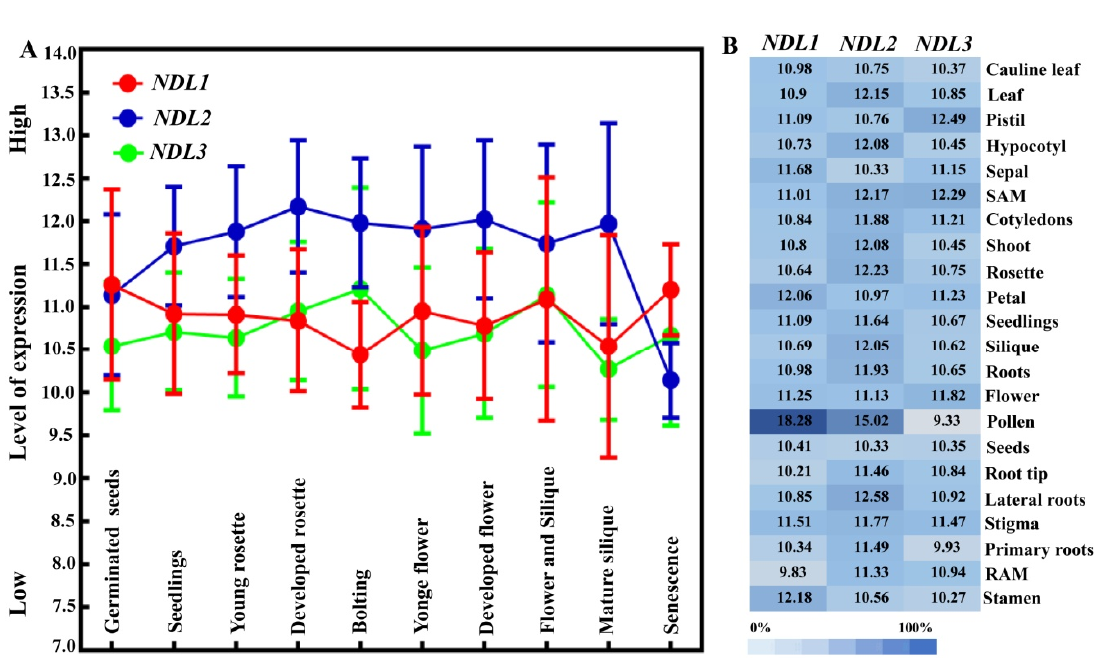
Figure 2. In silico expression analysis of NDL gene family. ( A ) GENEVESTIGATOR microarray expression analysis of NDL1 , NDL2 and NDL3 during di ff erent developmental stages of plant growth. ( B ) In silico microarray analysis showing tissue-specific expression of NDL1, NDL2, and NDL3 using GENEVESTIGATOR.